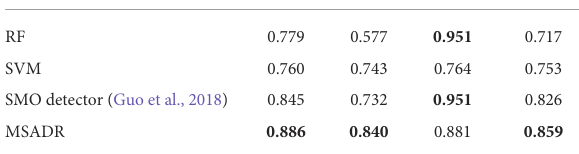
TABLE 1 Detection comparison of random forest (RF), support vector machine (SVM), SMO, and multi-head self-attention-based detector for recommendation (MSADR) trained using leave-one-out cross-validation on the entire